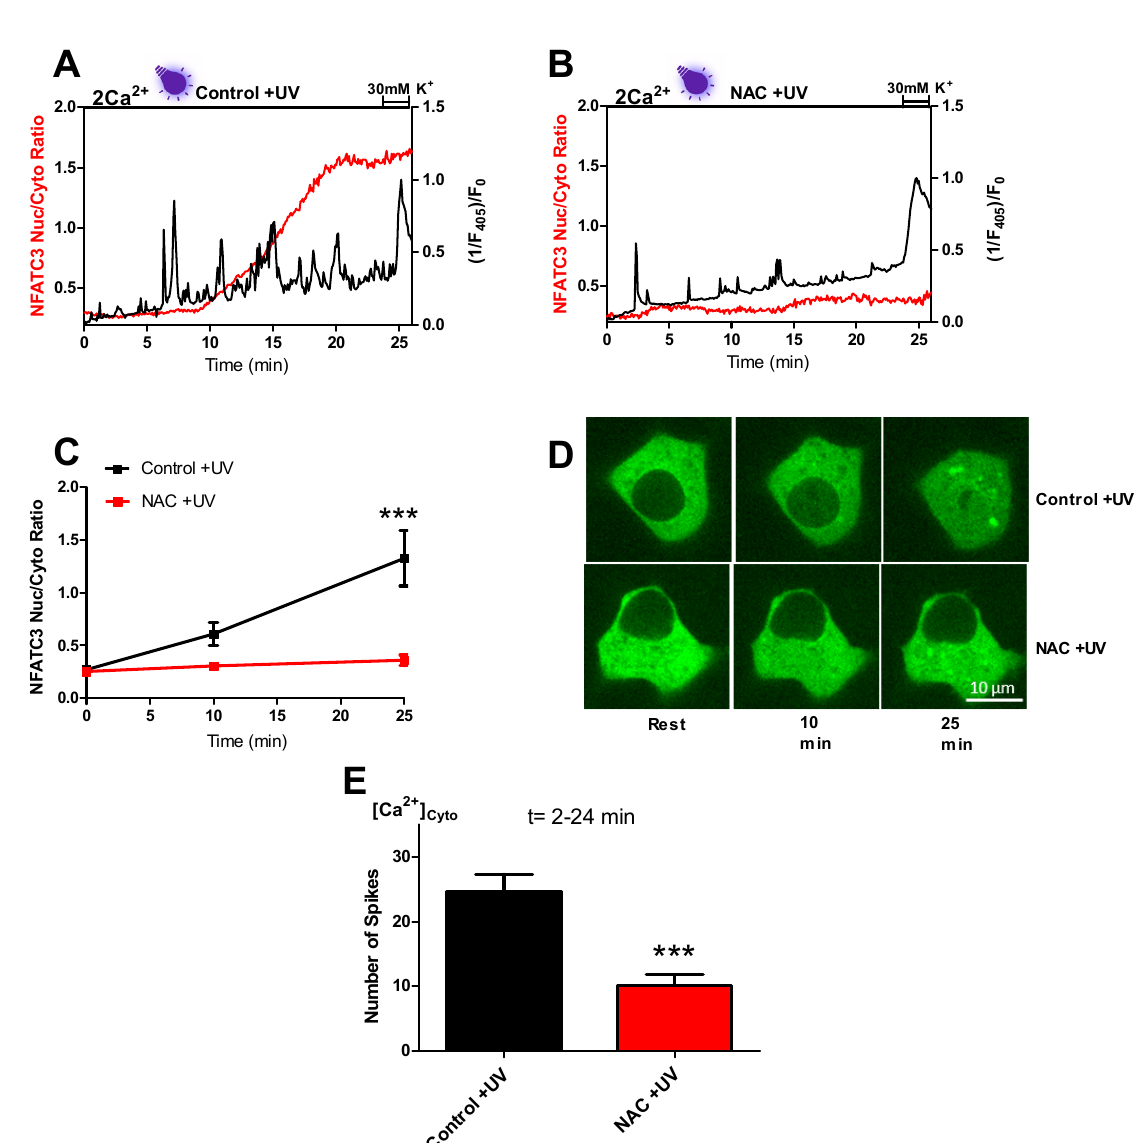
Figure 4. Near-UV light induced cytosolic Ca 2+ spiking, and GFP-NFATc3 translocation to the nucleus is diminished by the application of a ROS scavenger. Representative trace of repetitive cytosolic Ca 2+ spiking (black trace) measured with Fura-2 by exciting the cells with 405 nm laser line. Simultaneous GFP-NFATc3 translocation (red trace) was assessed by exciting the cells with 488 nm laser line in the cells perfused with 2 mM extracellular Ca 2+ solution in control +UV ( A ) and NAC +UV (1 mM) ( B ). Time course of GFP-NFATc3 translocation as MEAN ± SEM in control +UV (black) and NAC +UV (red) assessed by the ratio of nucleus to the cytosol ( C ). Representative images indicate the translocation of GFP-NFATc3 in INS-1 cells. The inserted white bar represents 10 µ m ( D ). Bar graphs represent the occurrence of cytosolic Ca 2+ spikes calculated in the time point between 2 and 24 min ( E ). Significant differences were assessed via unpaired t -test and presented as specific p -values (*** p < 0.001). Control +UV ( n = 18) and NAC ( n = 33).